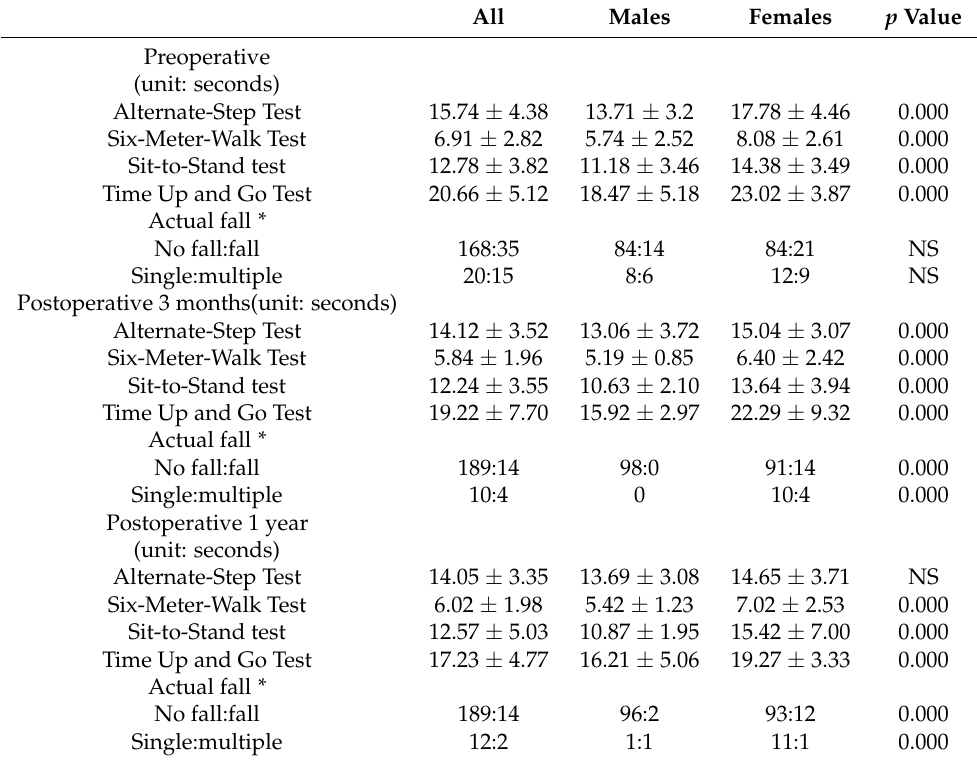
Table 2. Comparison of functional test results between male and female patients.